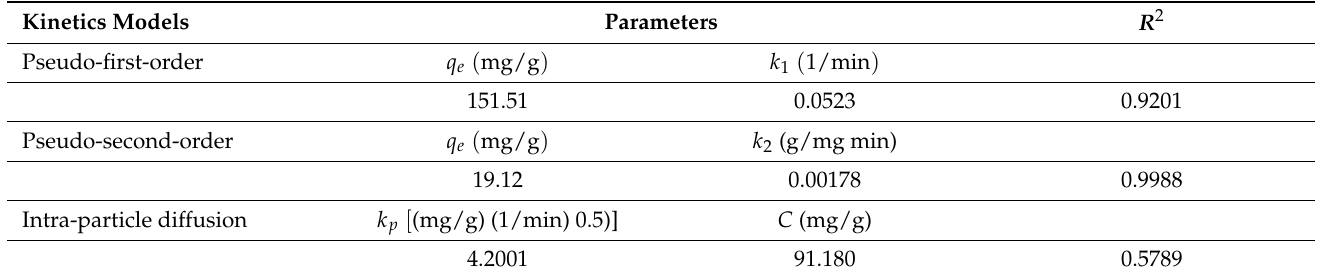
Table 1. Parameters of kinetics models for MB uptake by the BE/SD – MNPs composite.